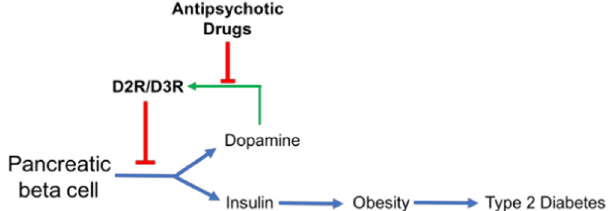
Fig. 1 Model for dopamine D2/3 receptor-mediated regulation of insulin release in the pancreatic beta cell. Dopamine acts through a dopamine D 2 /D 3 receptor (D2/D3R)-mediated autocrine negative- feedback mechanism to inhibit further insulin release. Left unchecked following APD treatment, chronic insulin release may promote adipogenesis, weight gain, insulin resistance, and ulti- mately type 2 diabetes. The fi gure was adapted from Rubí and Maechler [ Endocrinology 151(12): 5570 – 5581, 2010] with permission from Endocrinology and HighWire Press via Copyright Clearance Center